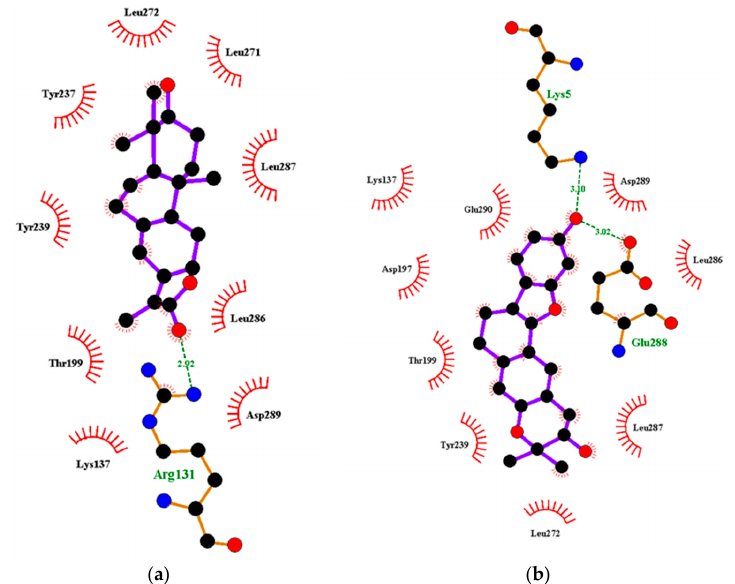
Figure 3. Two-dimensional diagrams of the M pro –ligand interactions generated using LigPlot+. ( a ) Interaction profiles of the M pro –NANPDB2245, and ( b ) M pro –ZINC000095486008 complexes. Ligands are colored in purple, hydrogen bonds are represented as green dash lines, and hydrophobic contacts are represented as red spoke arcs.